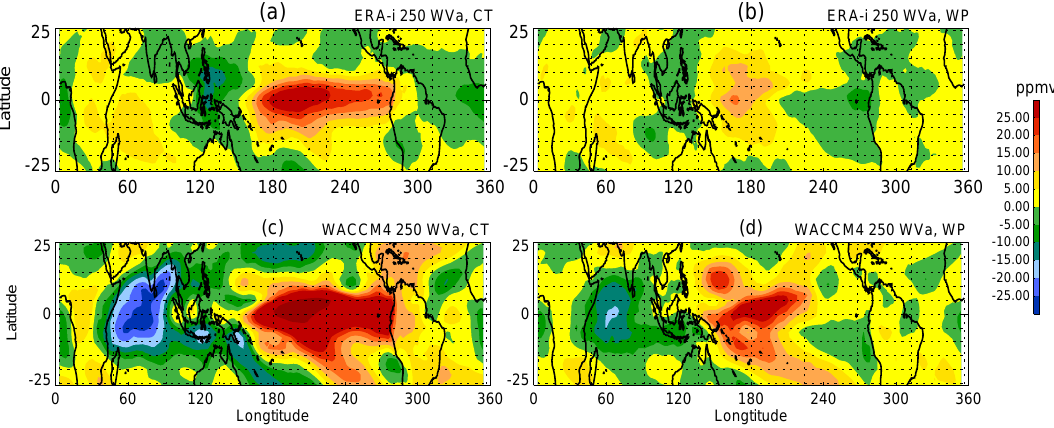
Fig. 6. Water vapor anomalies at 250hPa based on composite ERA-Interim data, 1979–2010: (a) canonical El Ni˜no events and (b) El Ni˜no Modoki events. Water vapor anomalies at 250hPa for R2–R1 (c) and R3–R1 (d) . Contour intervals, ± 5ppmv water